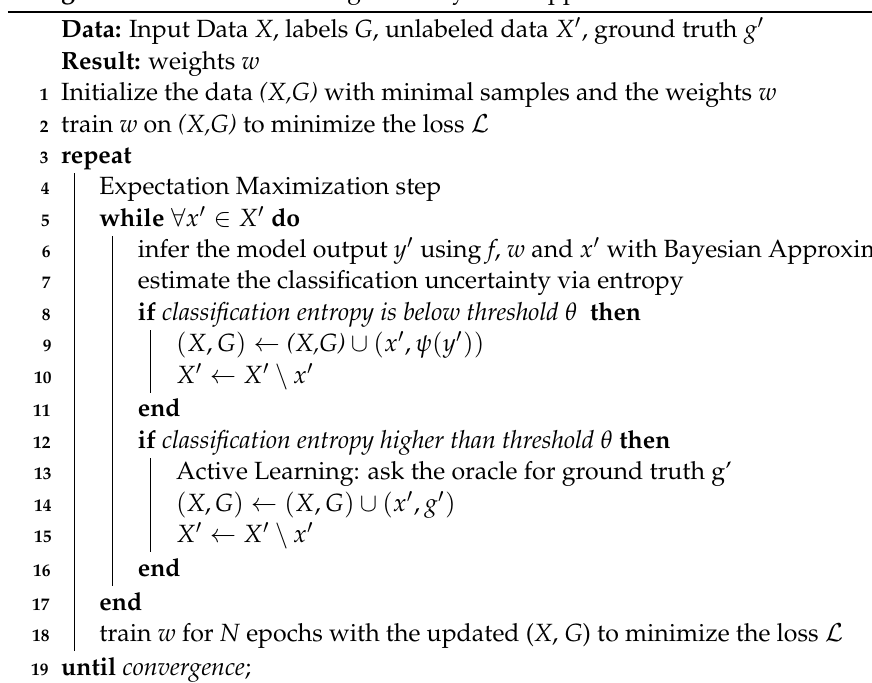
Algorithm 1: Active Learning with Bayesian